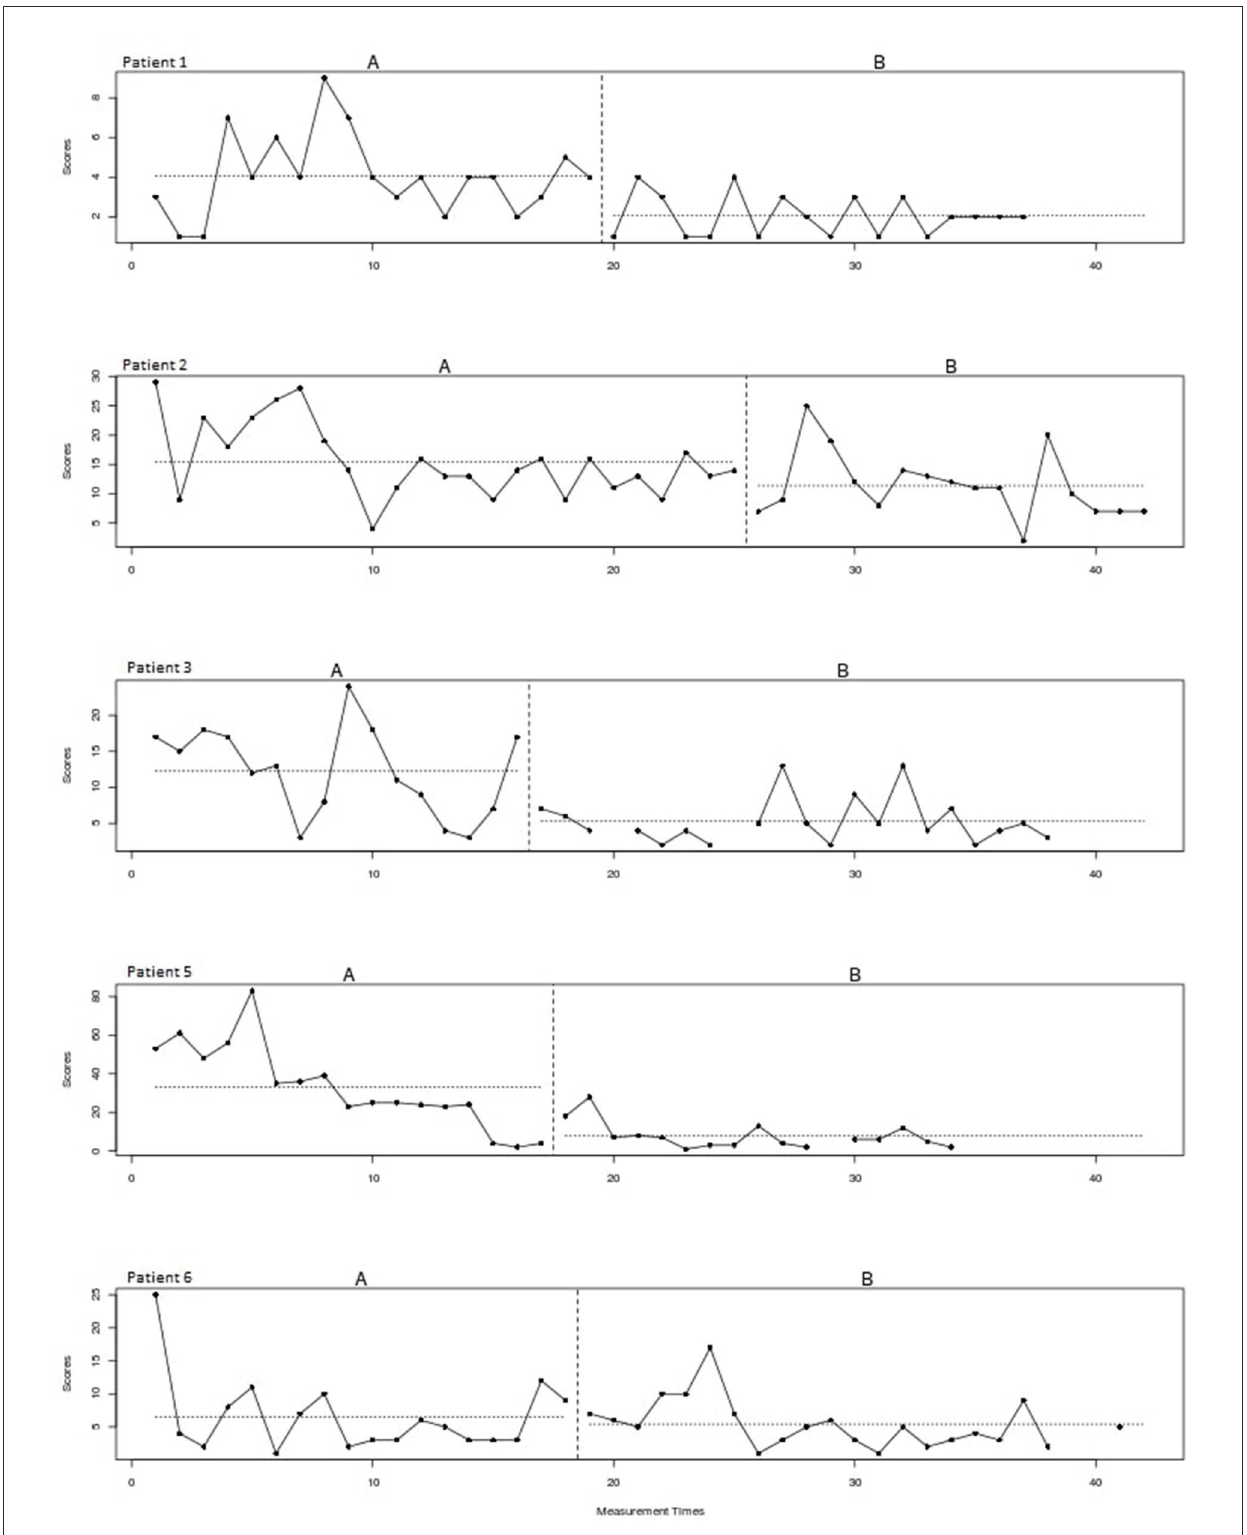
FIGURE2 Scratching behavior of individual patients over time for the baseline (A) and intervention (B)